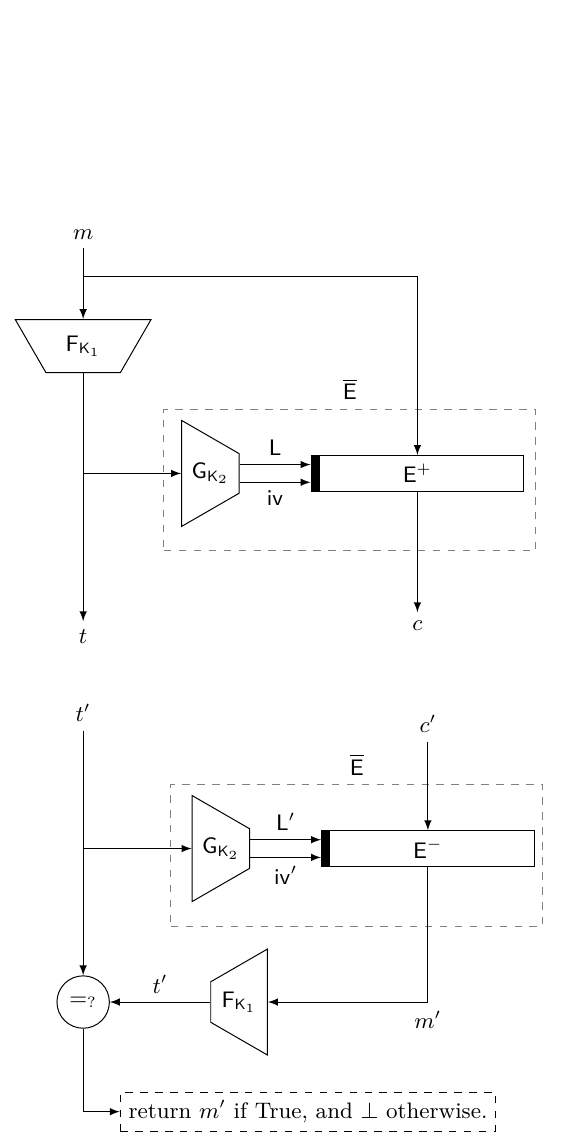
Figure 3.1: Encryption ( top ) and decryption ( bottom ) algorithms in MTProto-G . The dashed rectangle represents the IV-based encryption scheme E